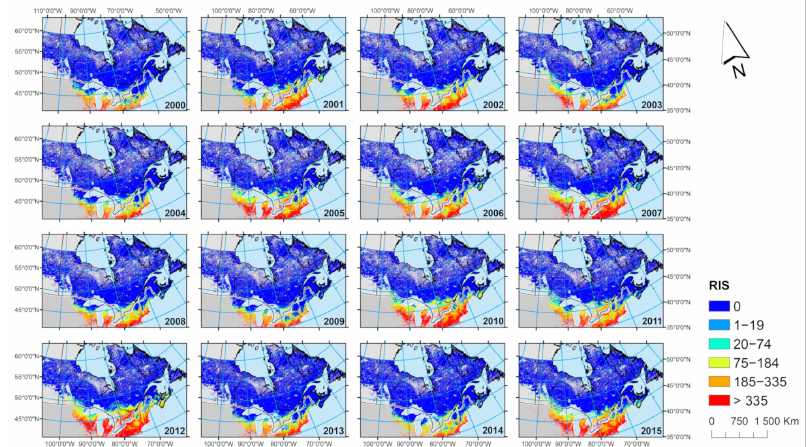
Figure 8. Maps of risk of I. scapularis (RIS) in Central and Eastern Canada from 2000 to